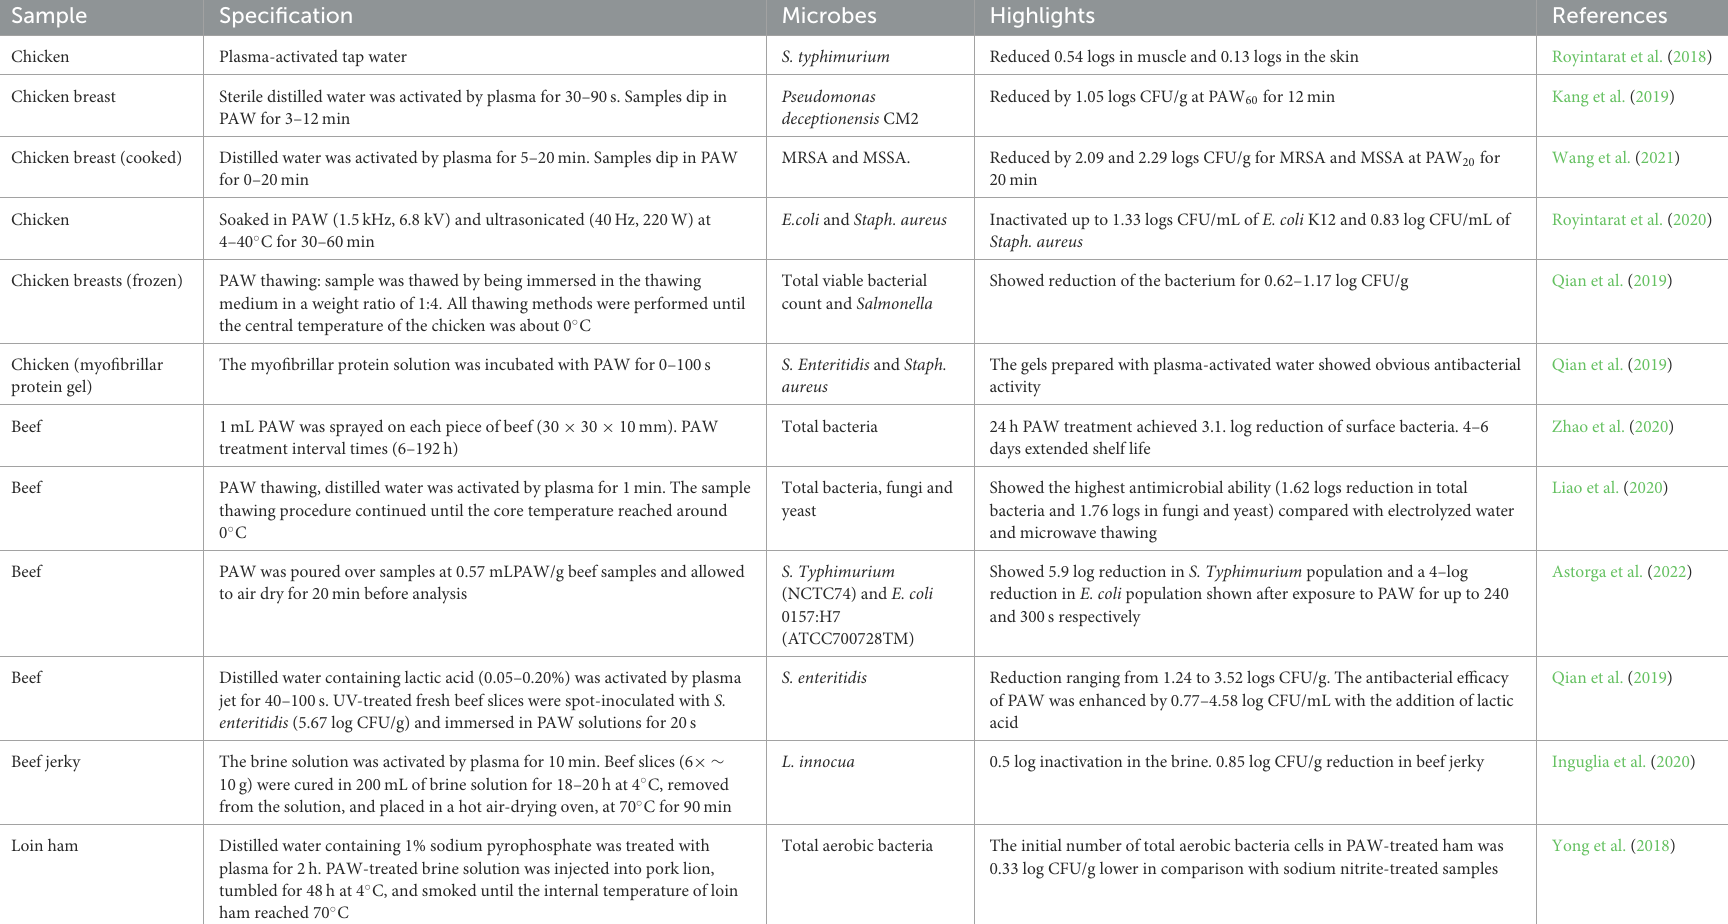
TABLE 3 A summary of studies reporting the decontamination of meat using plasma-activated water.